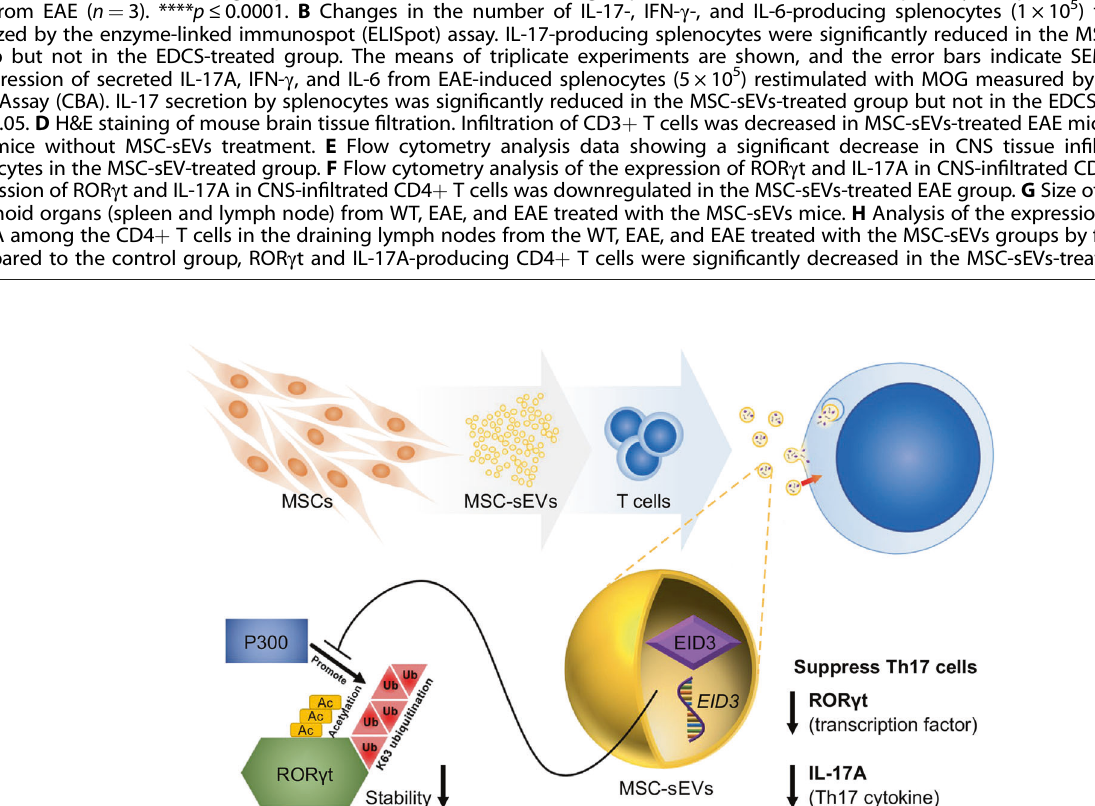
Fig. 5 Injection of MSC-sEVs in mice ameliorates EAE. A Effect of MSC-sEVs treatment in a mouse EAE model. EAE was induced by MOG/CFA coinjected with pertussis toxin (PTx). Here, 25 μ g of MSC-sEVs or sEVs-depleted supernatant (EDCS) was intravenously injected into EAE mice